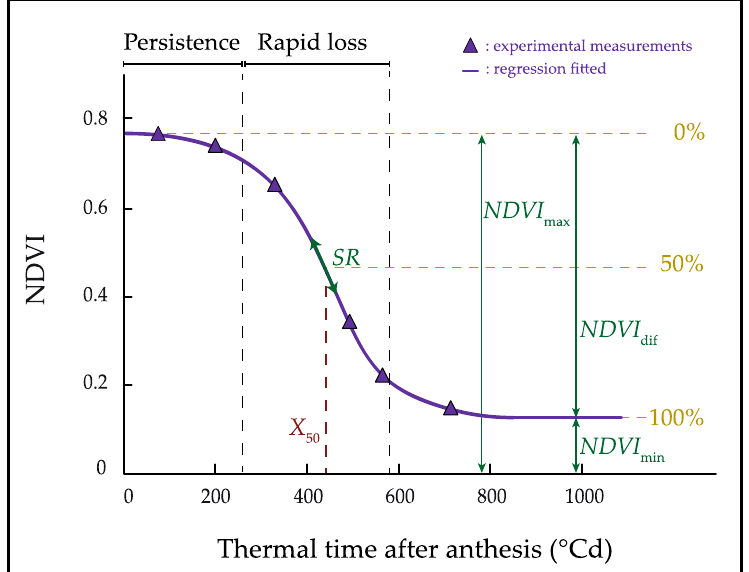
Figure 7. Graphical representation of the sigmoid function fitted for canopy senescence and the es- timated stay-green traits. SR indicate the rate of canopy senescence, NDVI max correspond to the max- imum canopy greenness ( NDVI max = NDVI dif + NDVI min ), and X 50 indicate the time when reach the maximum senescence rate (50% senescence).